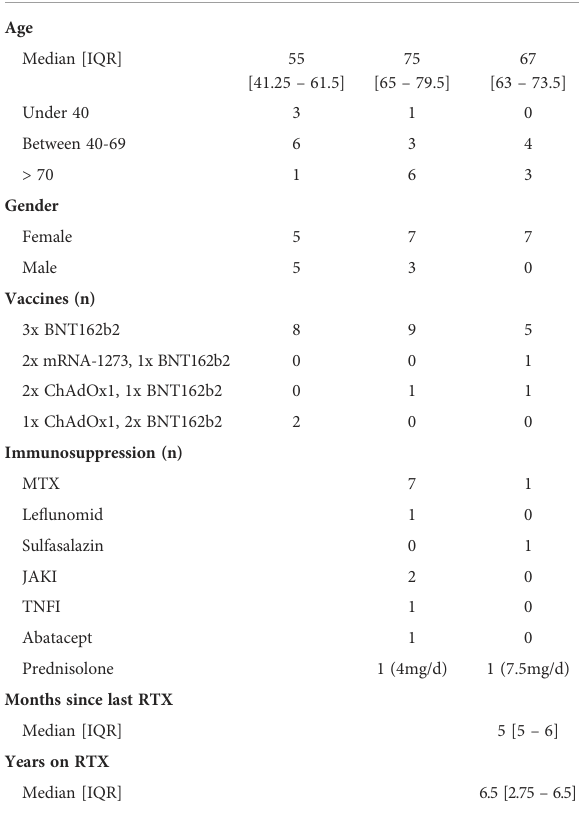
TABLE 1 Patient